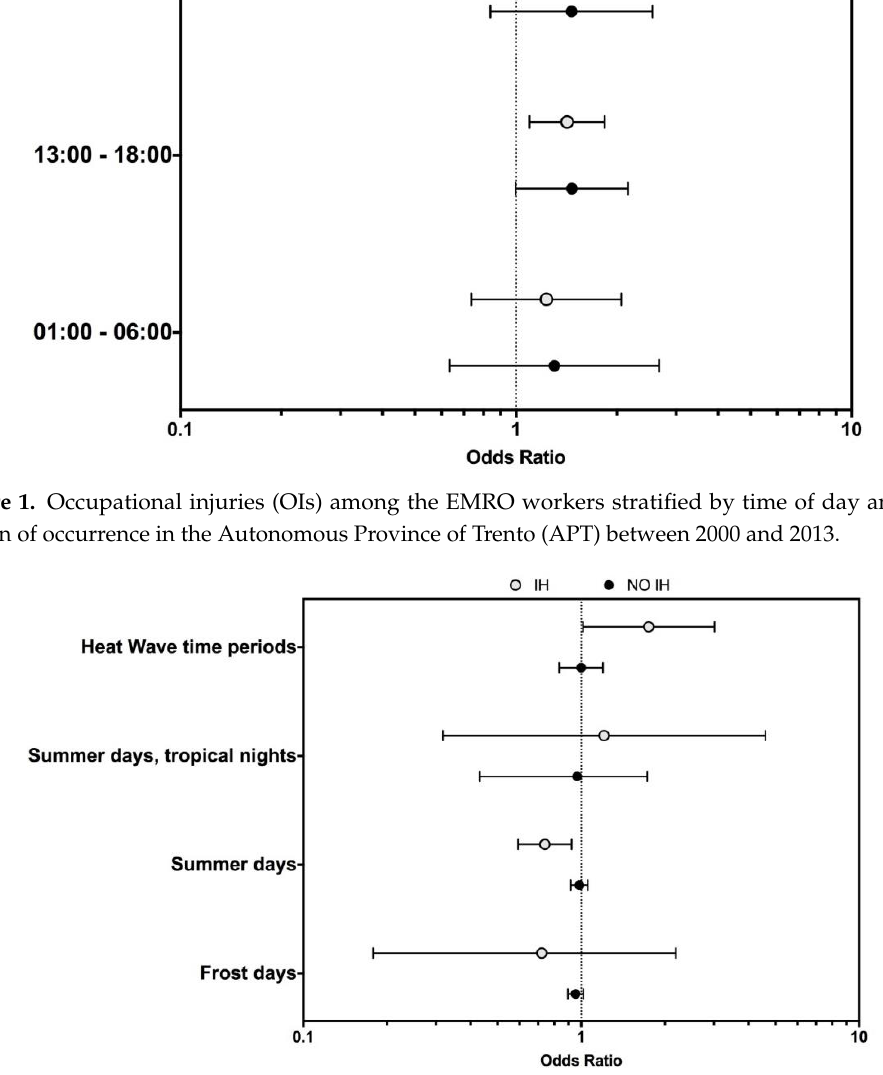
Table 5. Main meteorological indices regarding the assessed time period, broken down by percentiles.